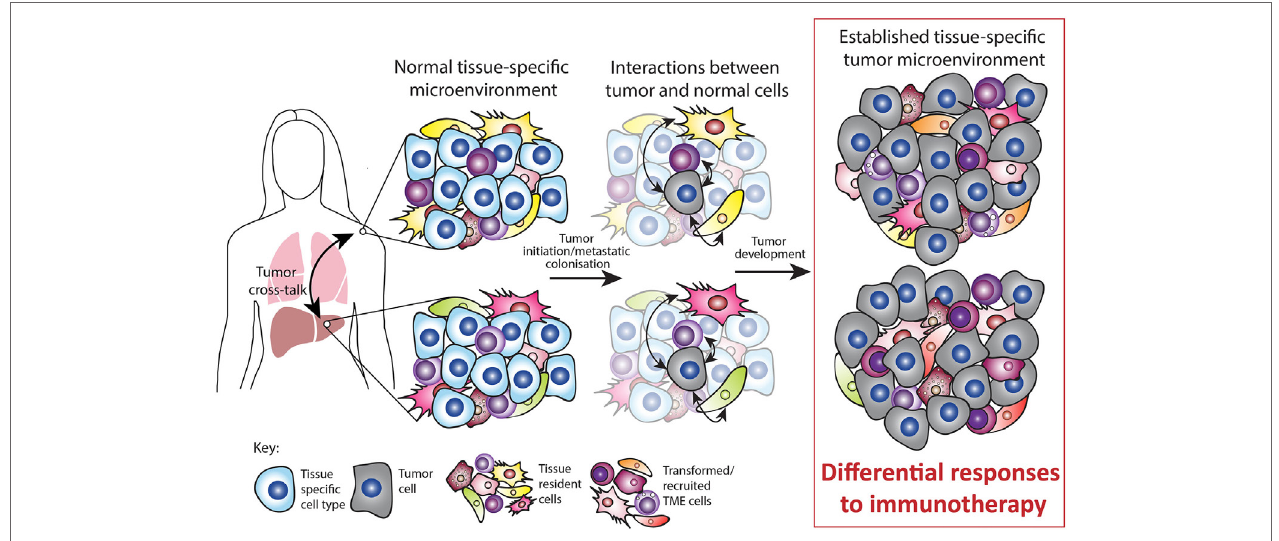
FigURe 2 | Tissue-specific tumor microenvironment (TME). Tumors can occur at various sites in the body and often occur simultaneously, for example, by metastatic growth. The normal tissue-specific microenvironment consists of both tissue-specific cell types and tissue-resident cell types such as immune, mesenchymal, and endothelial cells. Upon tumor initiation or metastatic colonization, interactions occur between tumor and normal cells. During tumor development, these interactions are partly responsible for the established TME. Both preclinical and clinical studies suggest that the tissue-specific TME mediates the response to immunotherapy. In addition, tumors occurring simultaneously within different TMEs can cross talk and influence each other. Thus, the normal tissue plays a major role in sculpting the established TME and this ultimately impacts on the response to